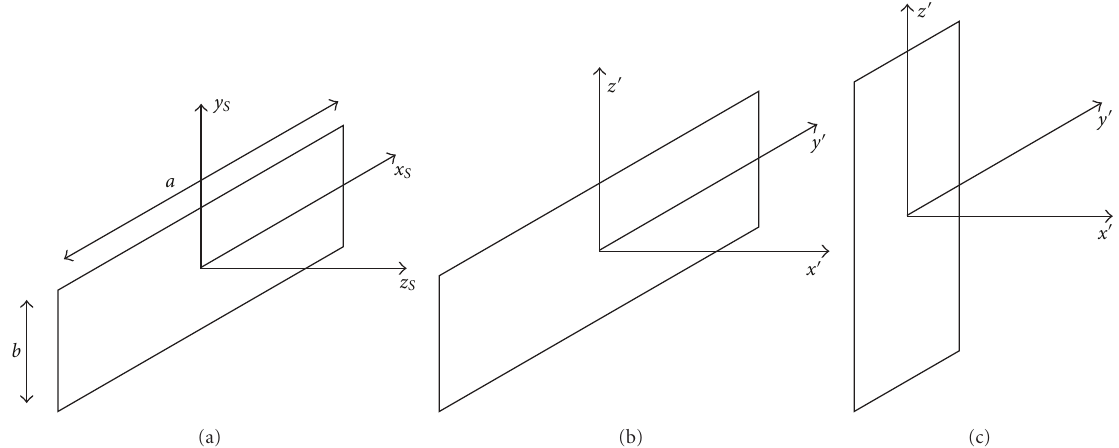
Figure 21: Reference systems relevant to the probe compensation. (a) Yaghjian’s. (b) vertical polarization. (c) horizontal polarization.